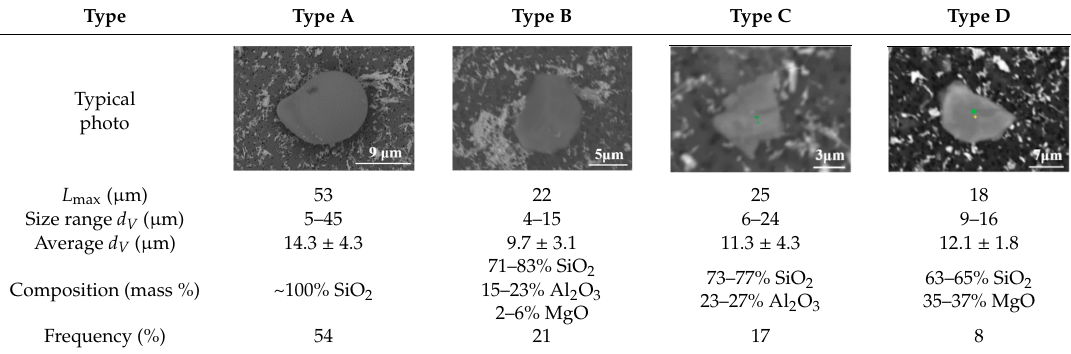
Table 3. Classification of inclusions in FeMo alloys.